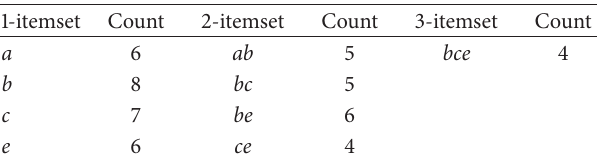
Table 5: Probability